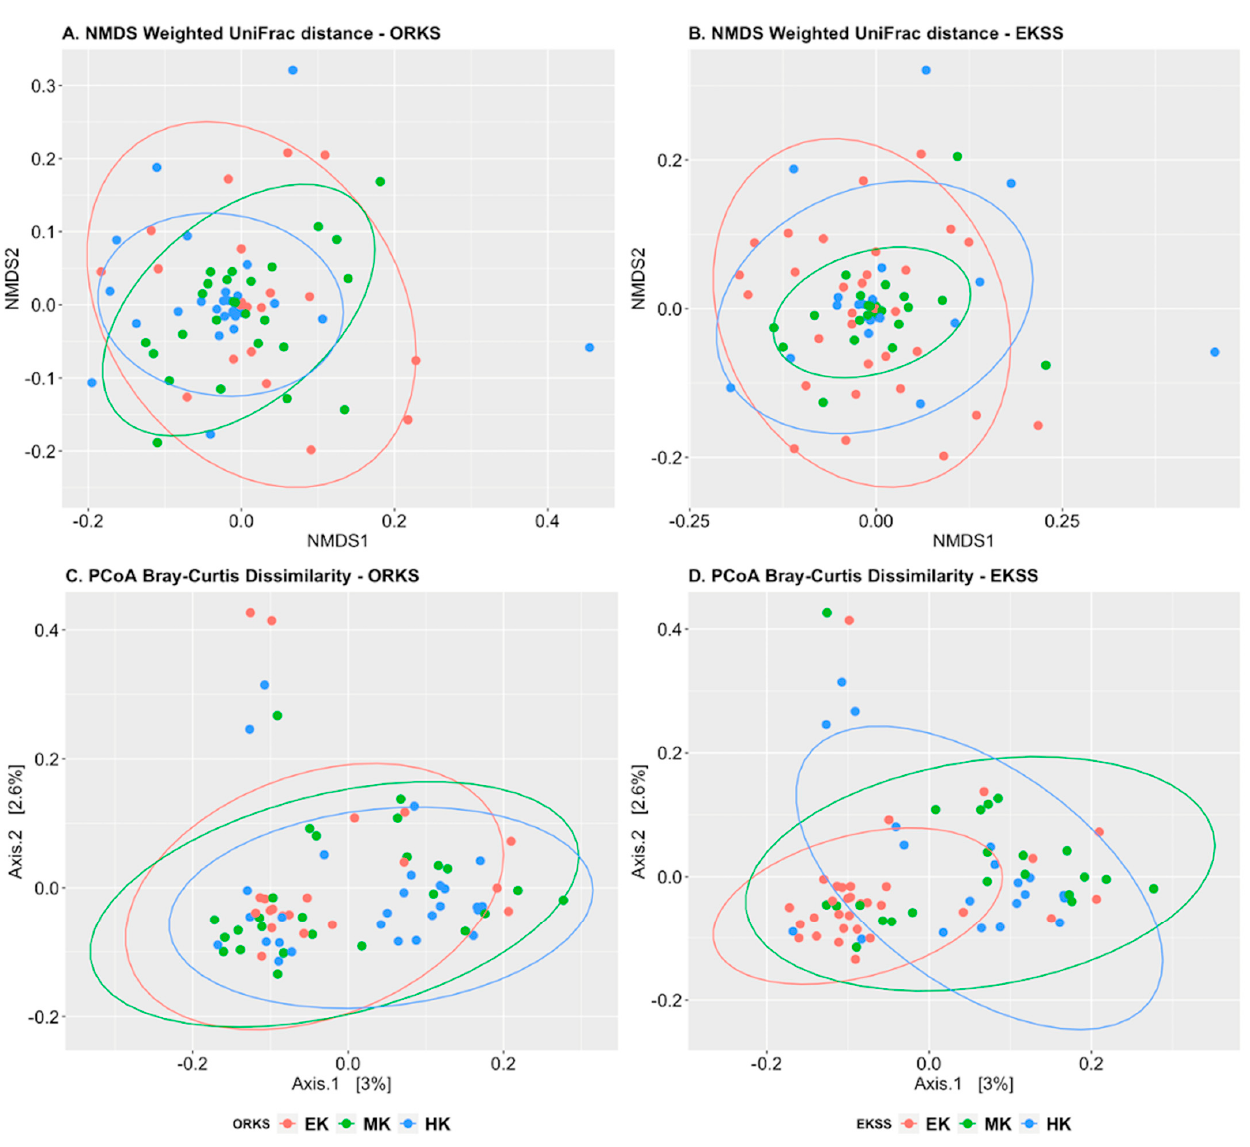
Figure 4. Beta diversity plots of owner reported keeper status (ORKS) and equine keeper status scale (EKSS). ( A ) Weighted Unifrac NMDS plot of ORKS. ( B ) Weighted Unifrac NMDS plot of EKSS. ( C ) Principal coordinate analysis (PCoA) plots of Bray–Curtis Dissimilarity plots of ORKS. ( D ) Principal coordinate analysis (PCoA) plots of Bray–Curtis Dissimilarity plots of EKSS Ellipsoids demonstrated at 95% confidence interval around each group. In both ORKS and EKSS plots easy keeper (EK) = red, medium keeper (MK) = green and hard keeper (HK) = blue.